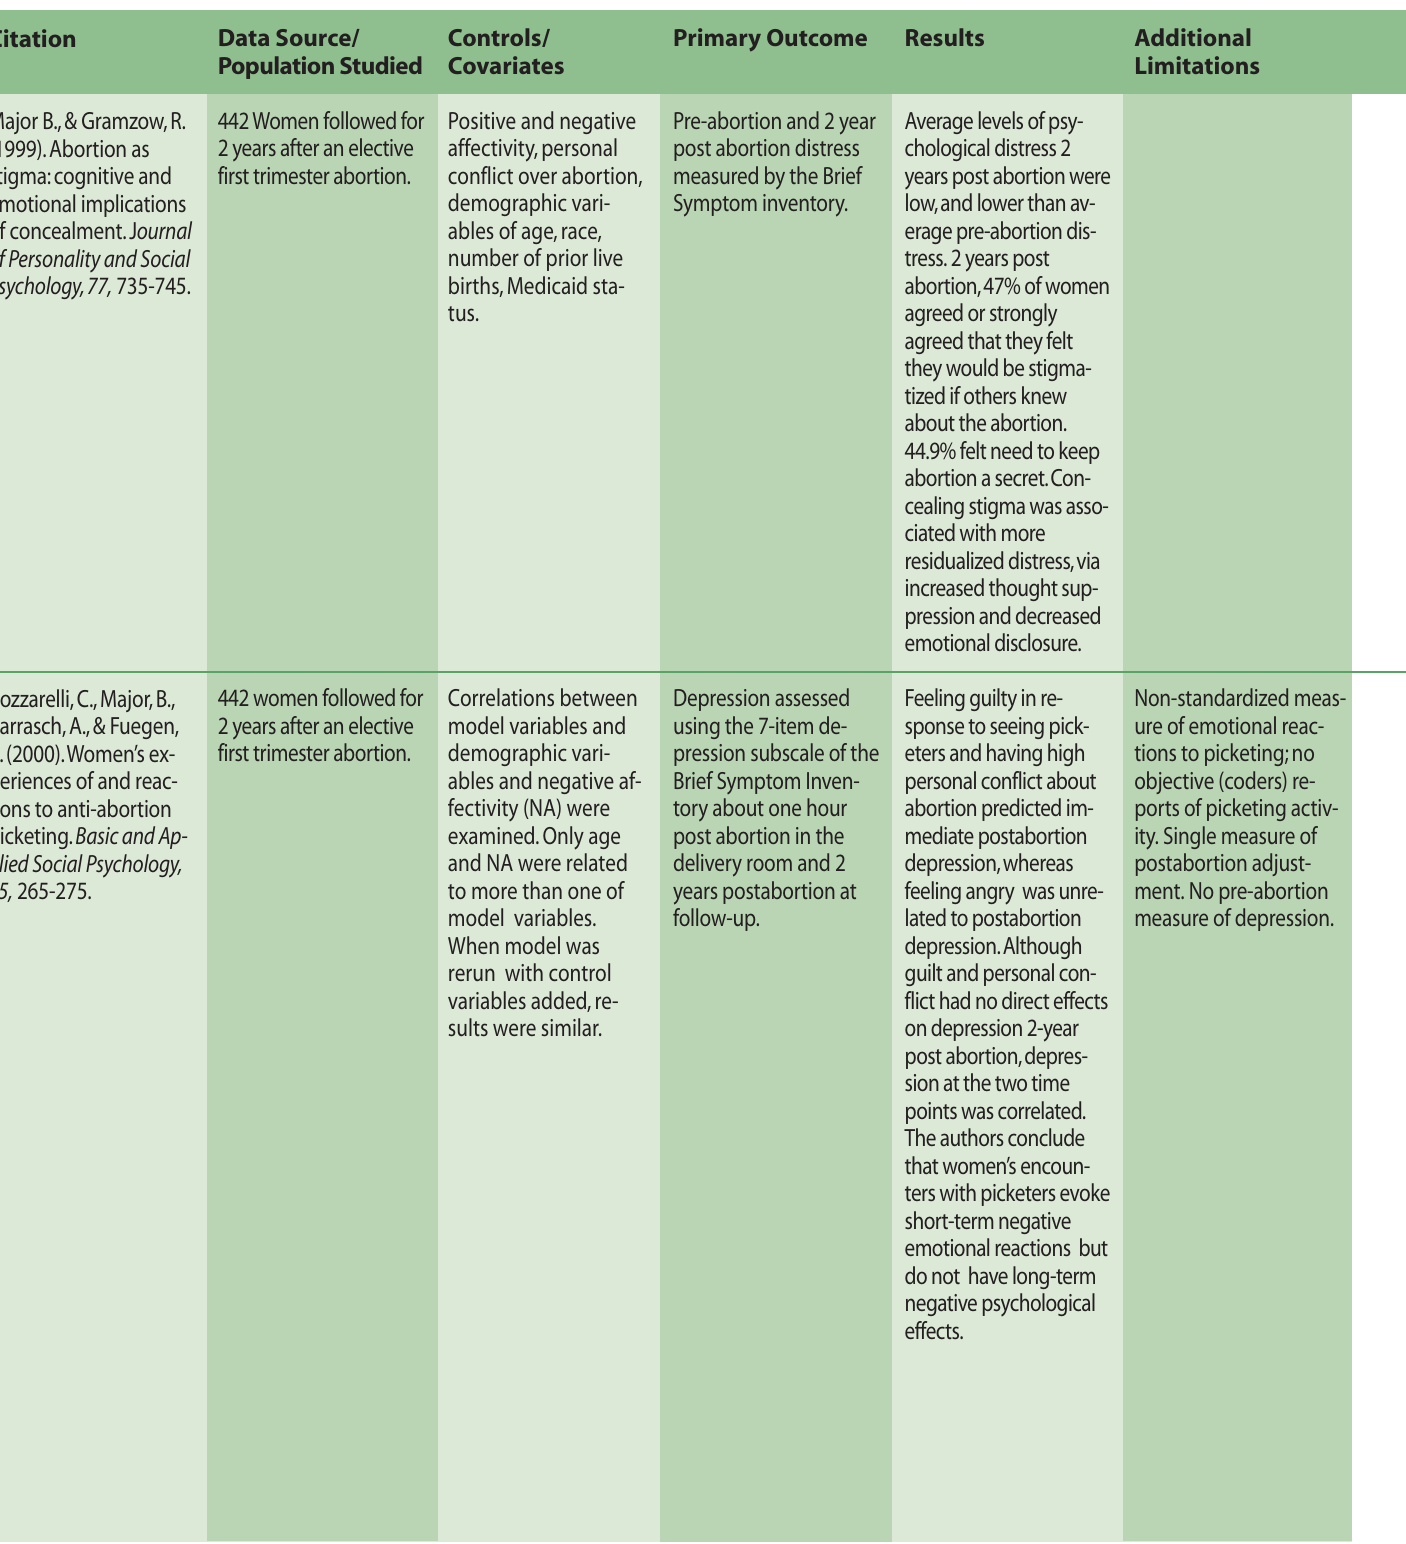
Table 5: U.S.Samples of Abortion Group(s) Only/No